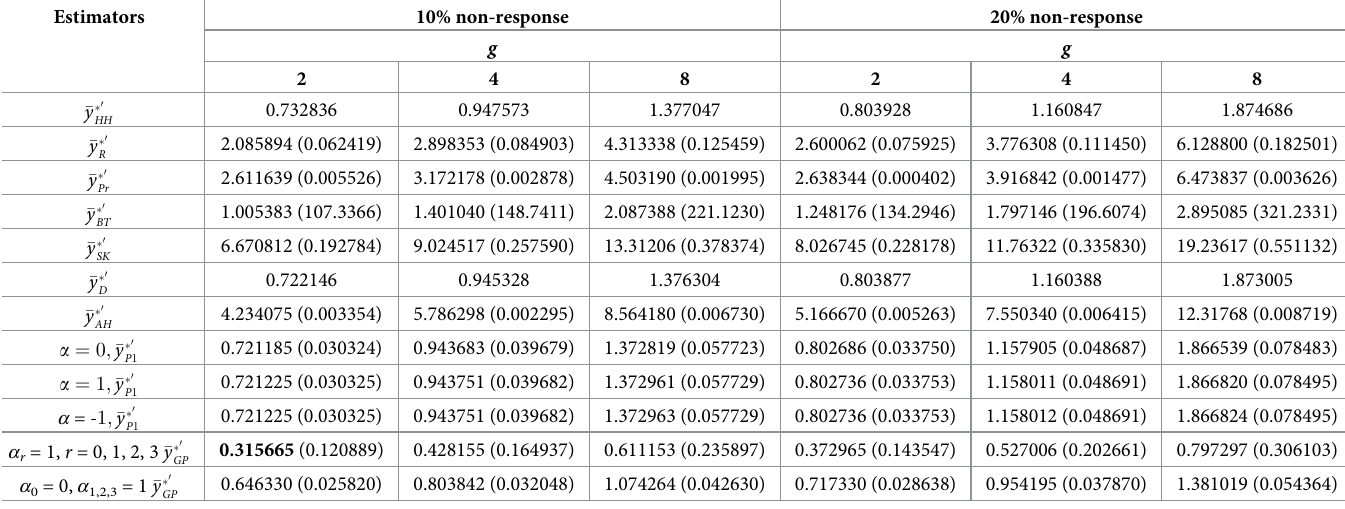
Table 12. Mean squared error and | Bias | (in brackets) values for different estimators for Population V without measurement error.